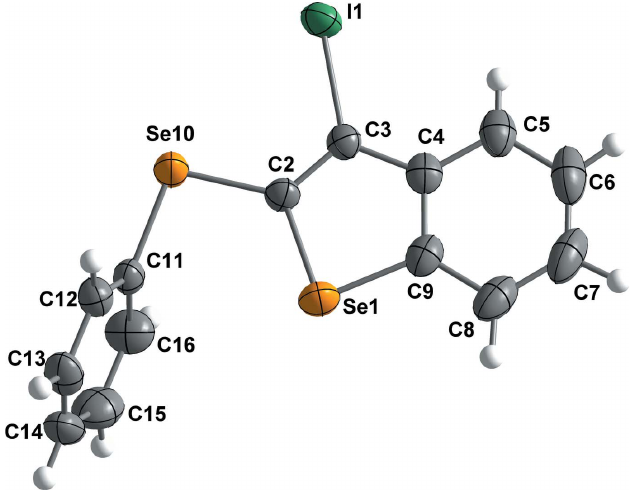
Figure 4 The molecular structure of 3-iodo-2-(phenylselanyl)benzo[ b ]selenophene ( 4 ), with displacement ellipsoids drawn at the 50% probability